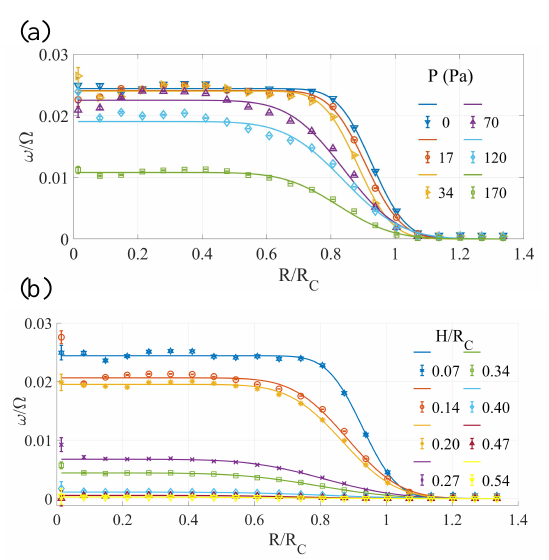
Figure 2. Shear band profile, ω ( r ) / Ω , versus normalised ra- dius for (a) di ff erent pressures at the normalised filling height H / R C = 0 . 07, and (b) di ff erent filling heights under the constant external pressure P = 0. The error bars in most cases are smaller than the symbols